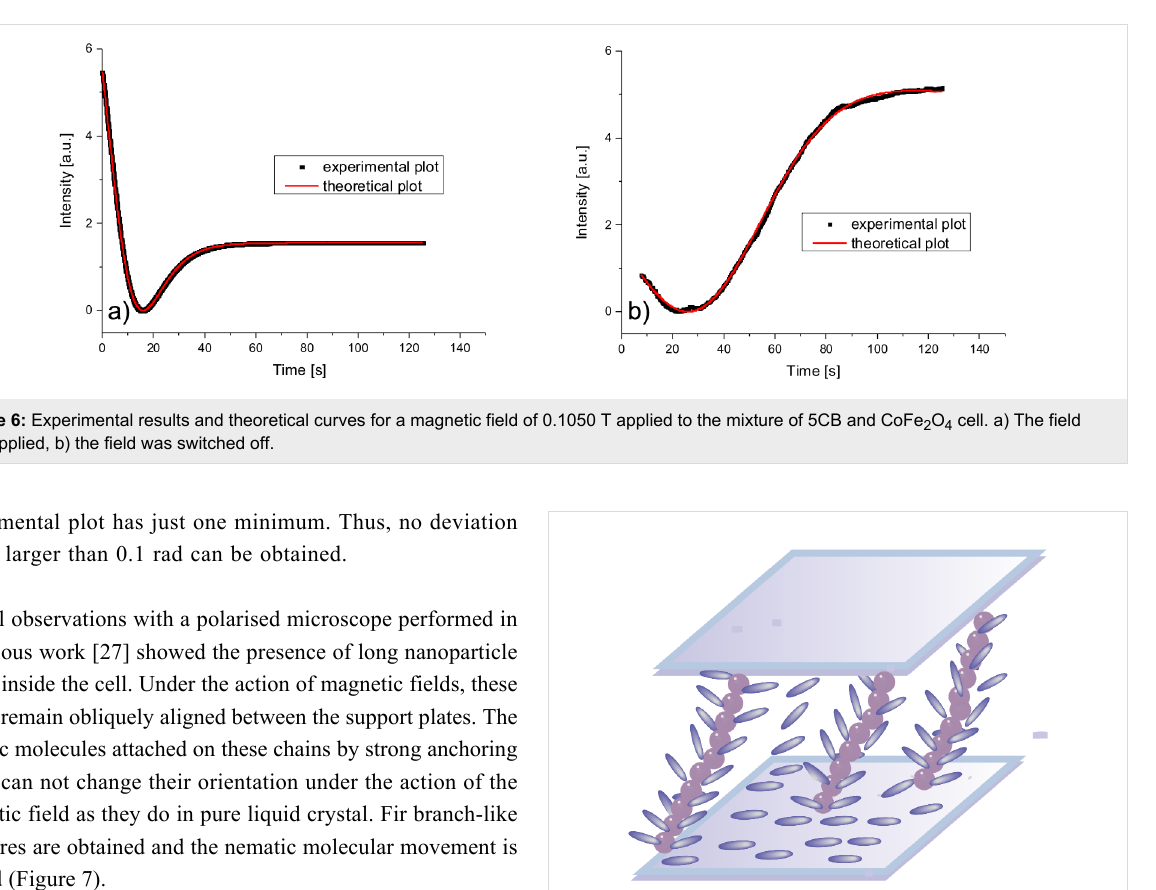
Figure 7: Fir branch-like structure in the cell with the mixture of 5CB with CoFe 2 O 4 .